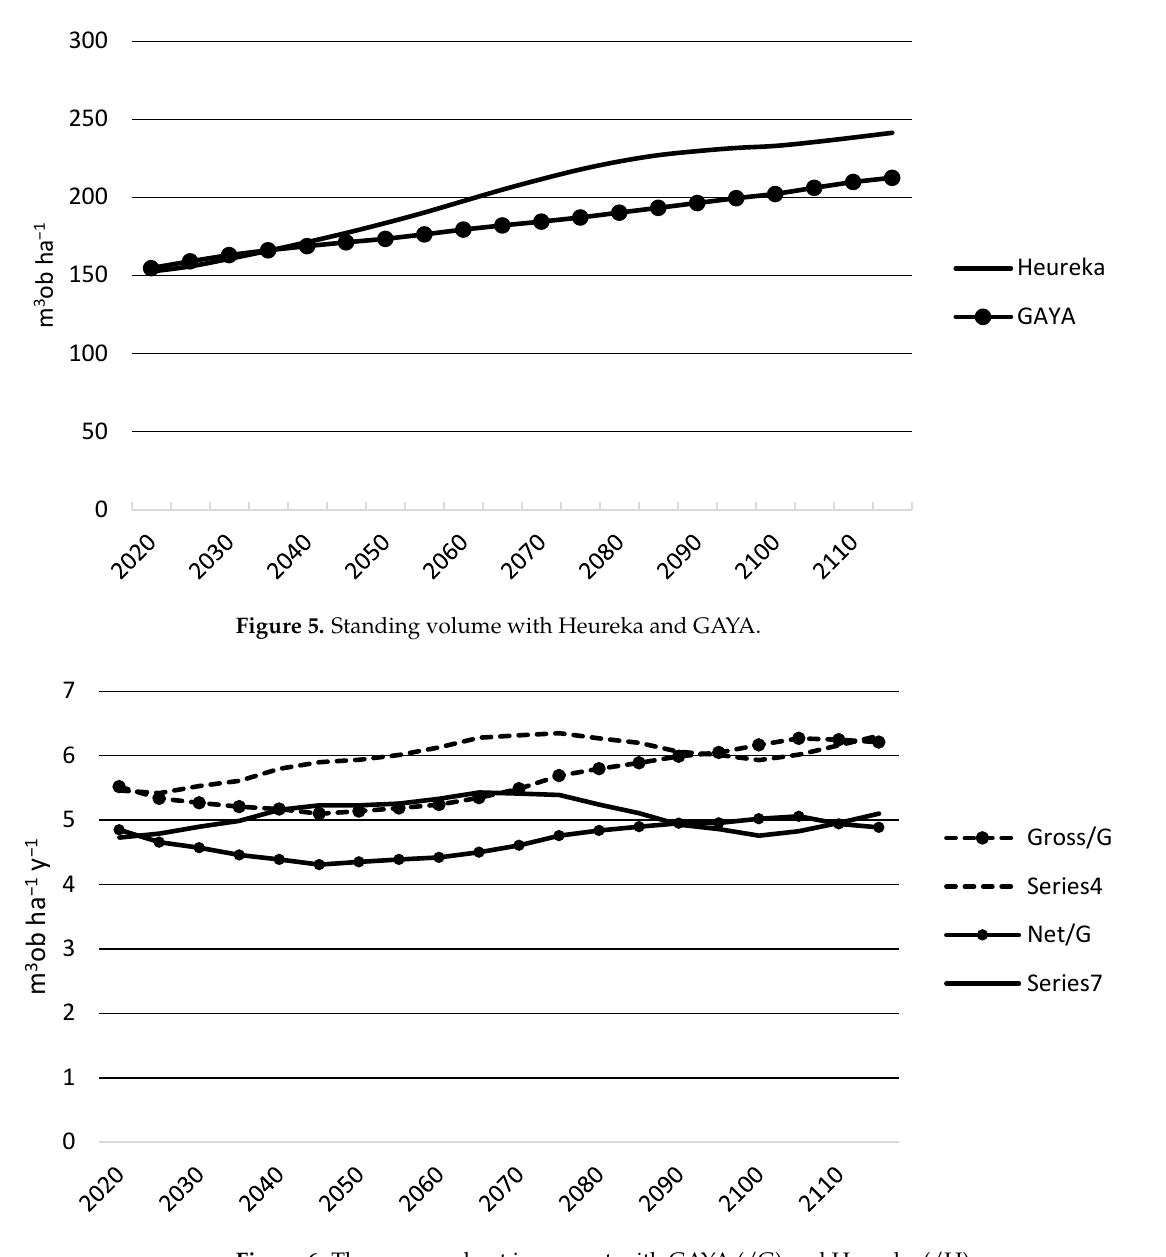
Figure 6. The gross and net increment with GAYA (/G) and Heureka (/H).